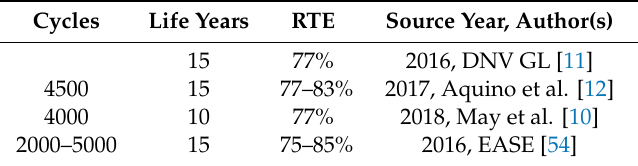
Table 20. Cycles, life years, and RTE—sodium-sulfur